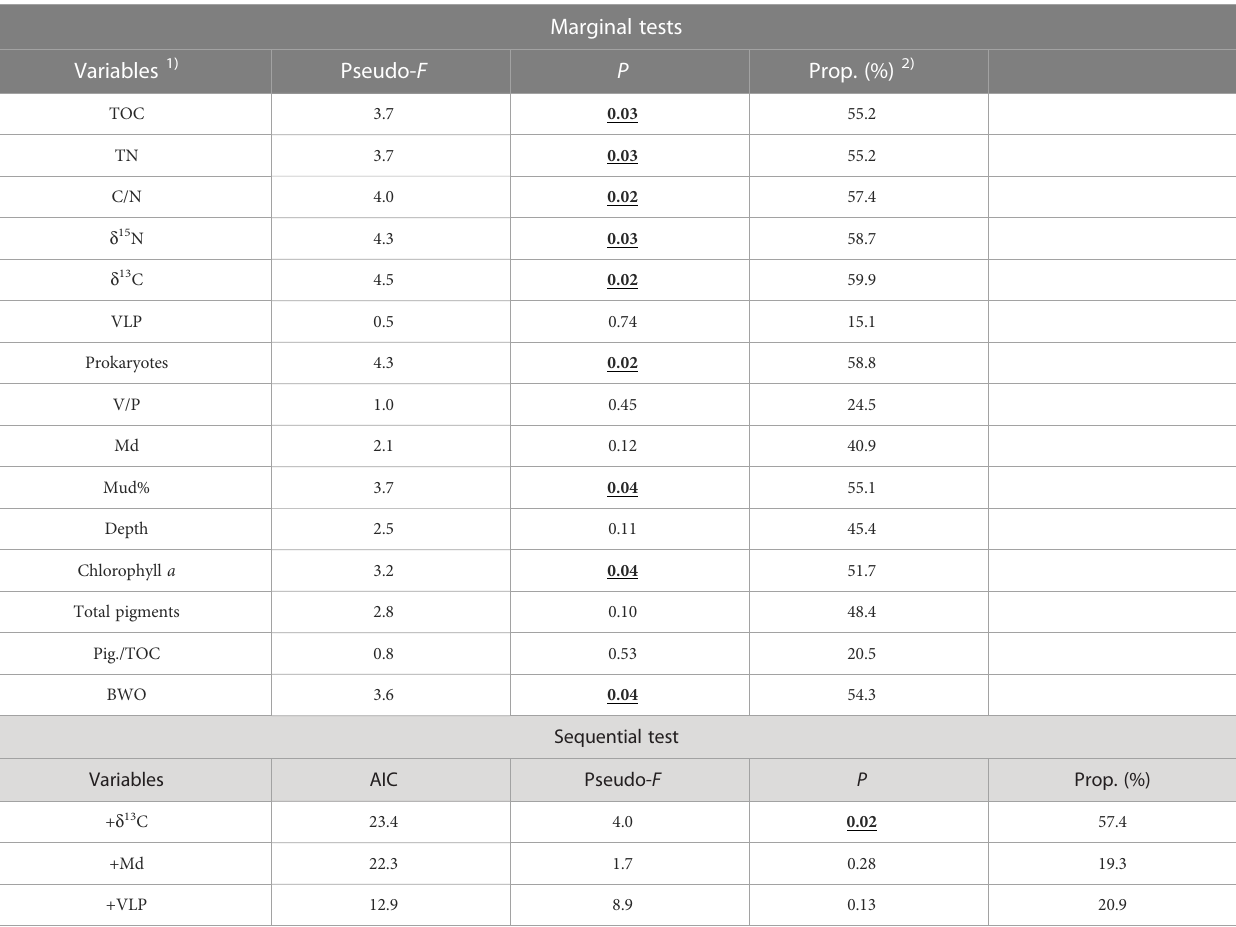
TABLE 2 Distance-based linear model (DISTLM) analyses of meiofaunal community structure and their explanation by environmental parameters at fi ve stations in the southeastern Bering